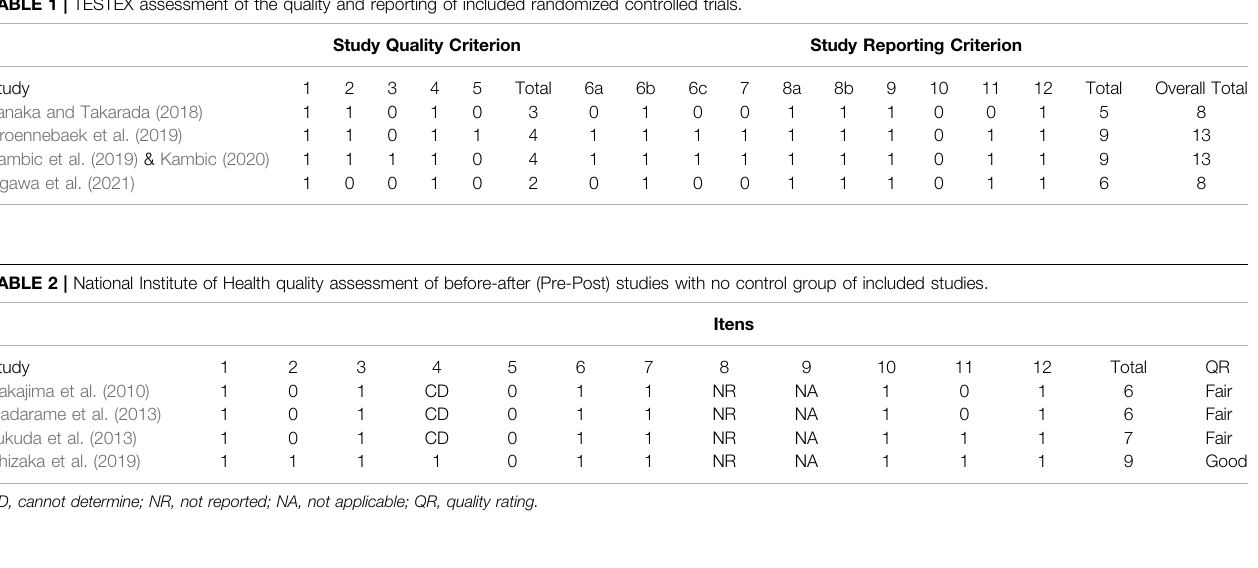
TABLE 1 | TESTEX assessment of the quality and reporting of included randomized controlled